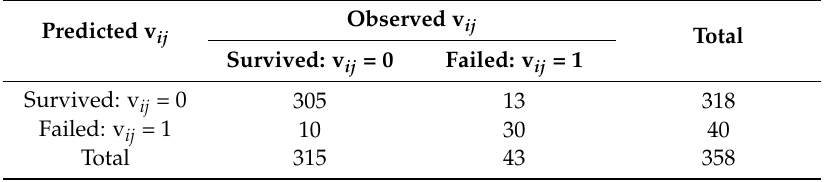
Table 6. Classification table for a discrete hazard model of Equation (19f) with c = 0.5.